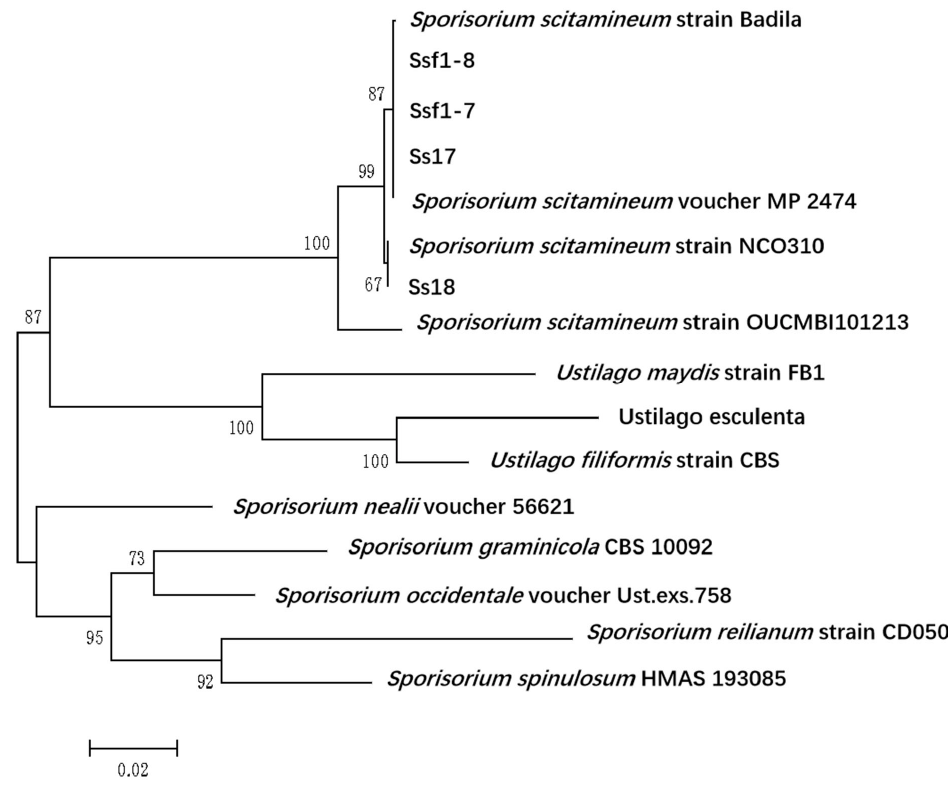
Figure 4. Phylogenetic analysis of ITS DNA sequences of S. scitamineum and other smut fungi. The phylogenetic tree is calculated with Maximum Likelihood using Mega ver. 6.0 software based on a Clustal W alignment. The following ITS DNA sequences were chosen for compar- ison: ITS of Ssf1-7, Ssf1-8, Ss17 and Ss18 of S. scitamineum , ITS sequences of Sporisorium